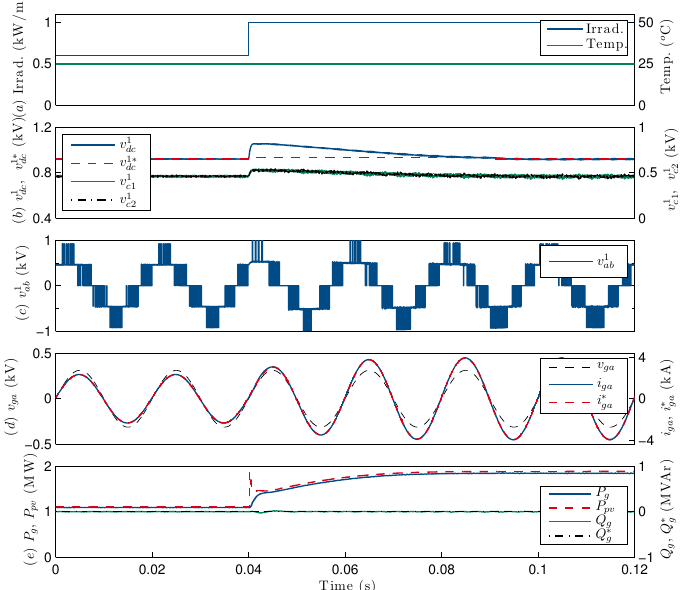
Figure 13. Dynamic results during an irradiance step from 0.6 to 1.0 kW/m 2 under clean grid: ( a ) Irradiance and temperature levels; ( b ) capacitor and dc-link voltages; ( c ) converter output voltage; ( d ) voltage and current grid with its reference; ( e ) active and reactive with their references.